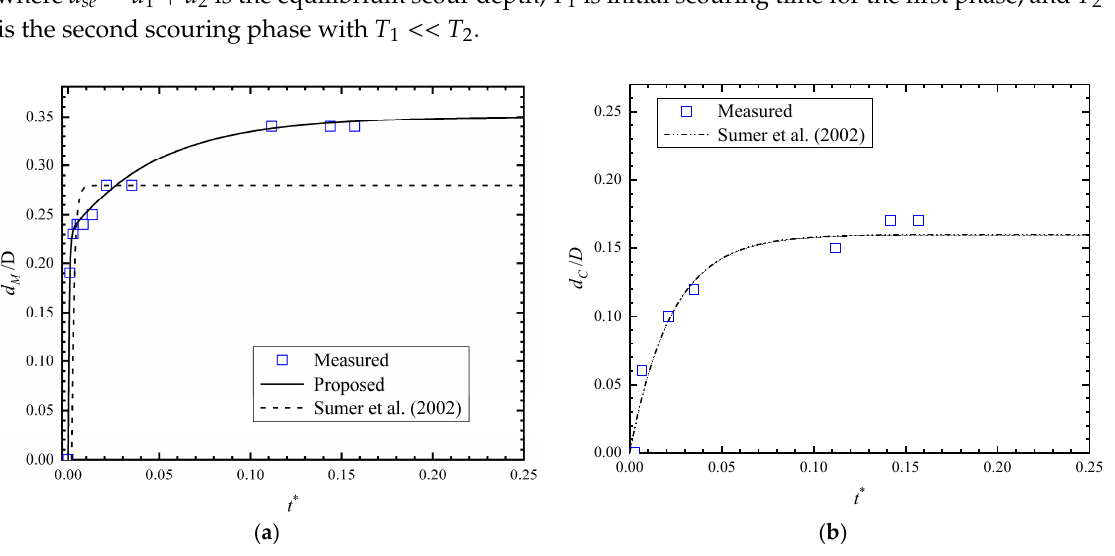
Figure 4. Non-dimensional scour depth evolutions for test 1. ( a ) Upstream corner scour depth evolution; ( b ) Center of upstream scour depth evolution.